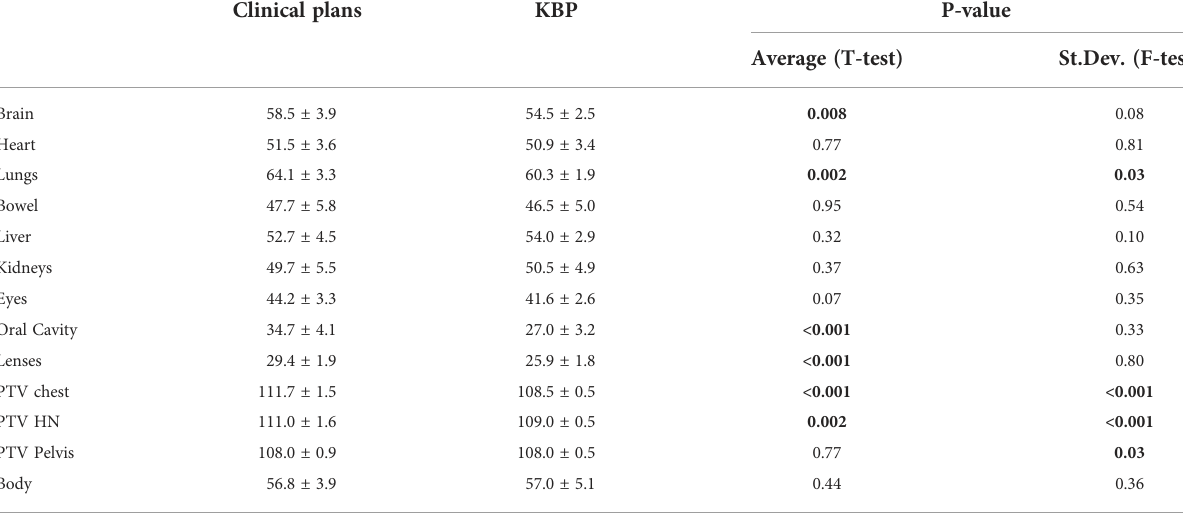
TABLE 2 Comparison of mean dose values of OAR (% of prescribed dose). Clinical plans KBP P-value Average (T-test) St.Dev. (F-test)